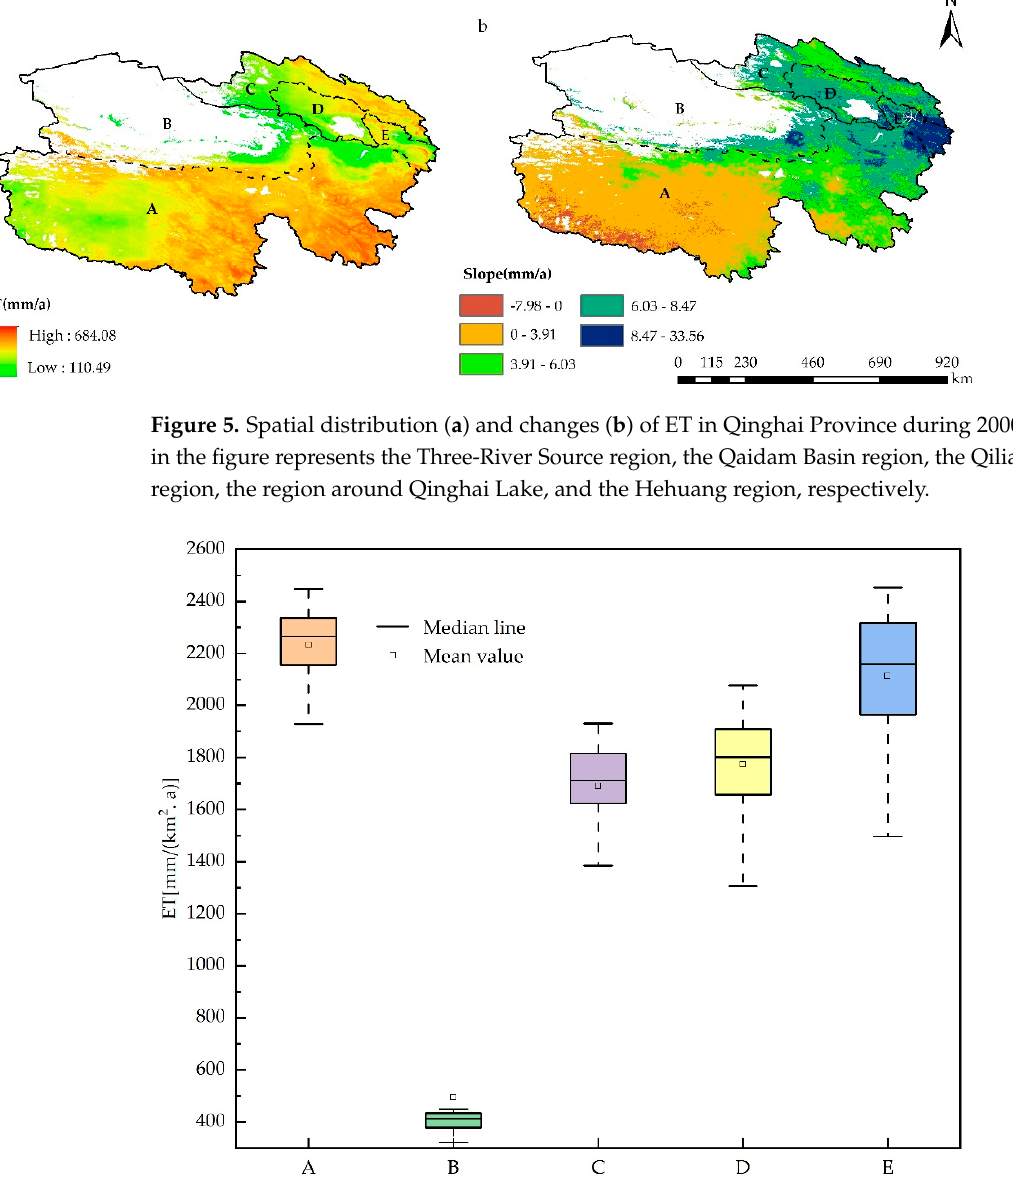
Figure 6. Characteristics of ET per unit region in five ecological function zones in Qinghai Province during 2000–2020. A–E in the figure represents the Three-River Source region, the Qaidam Basin region, the Qilian Mountain region, the region around Qinghai Lake, and the Hehuang region, respectively.